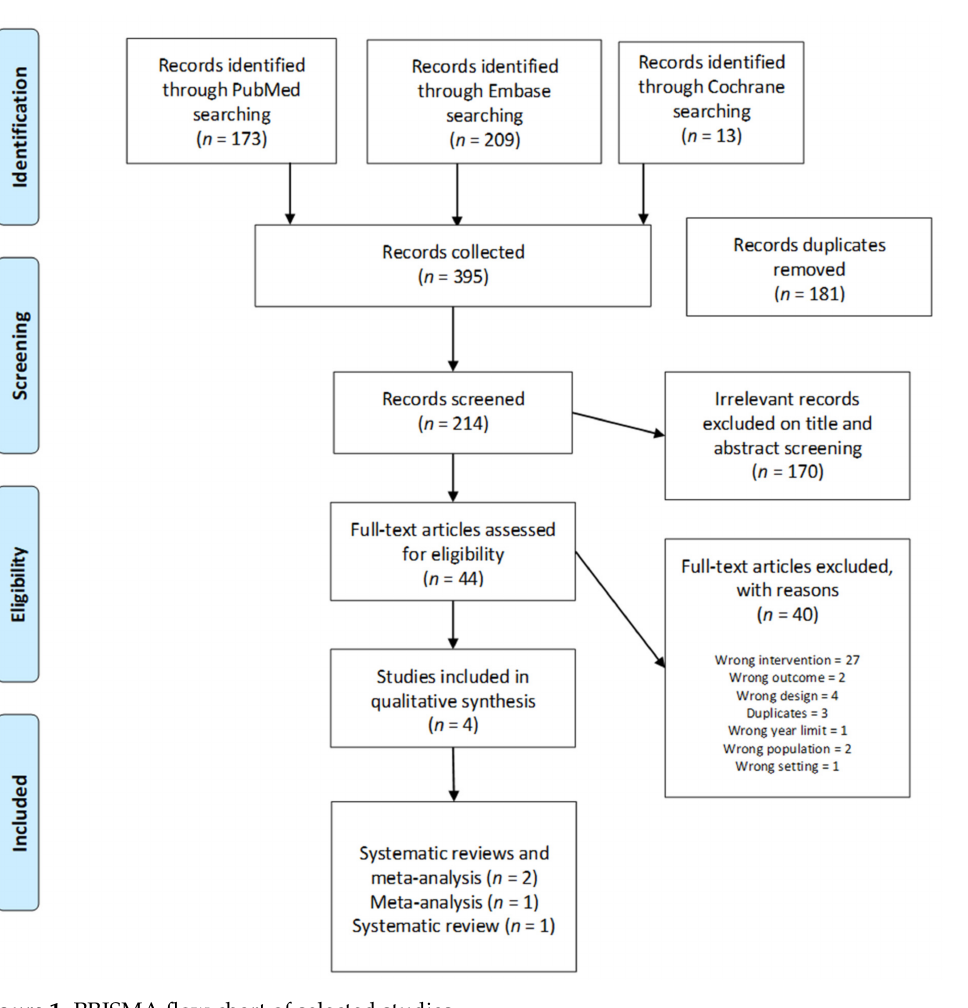
Figure 1. PRISMA flow chart of selected